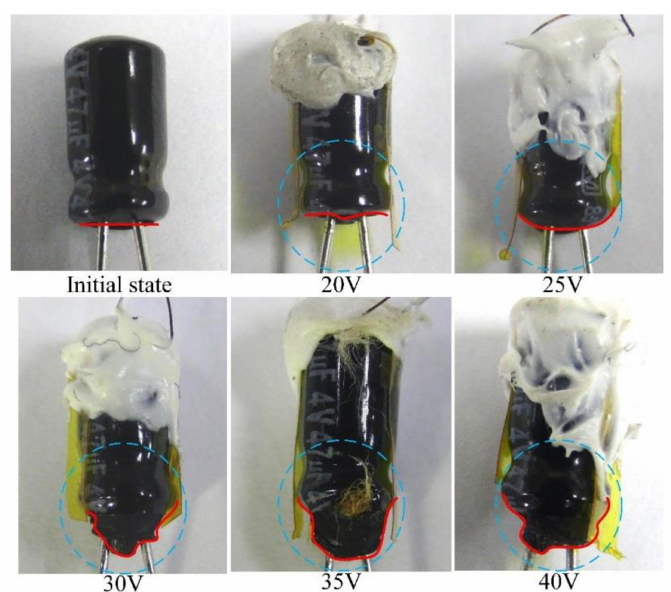
Figure 9. The final state of the capacitors with various applied